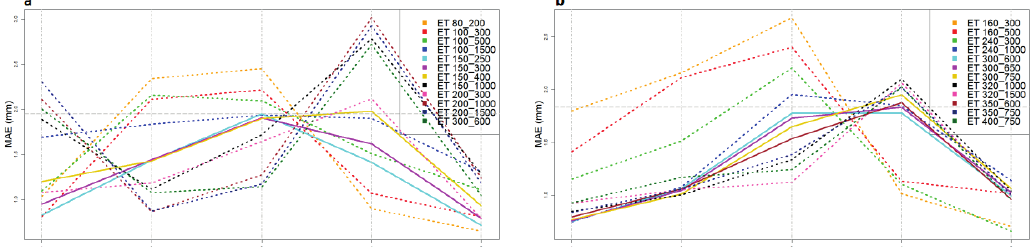
Fig. 3 Five-days MAE (mean absolute error) between ET (simulated from 12 surface resistance combinations) and LE in (a) deciduous forest and (b) pine